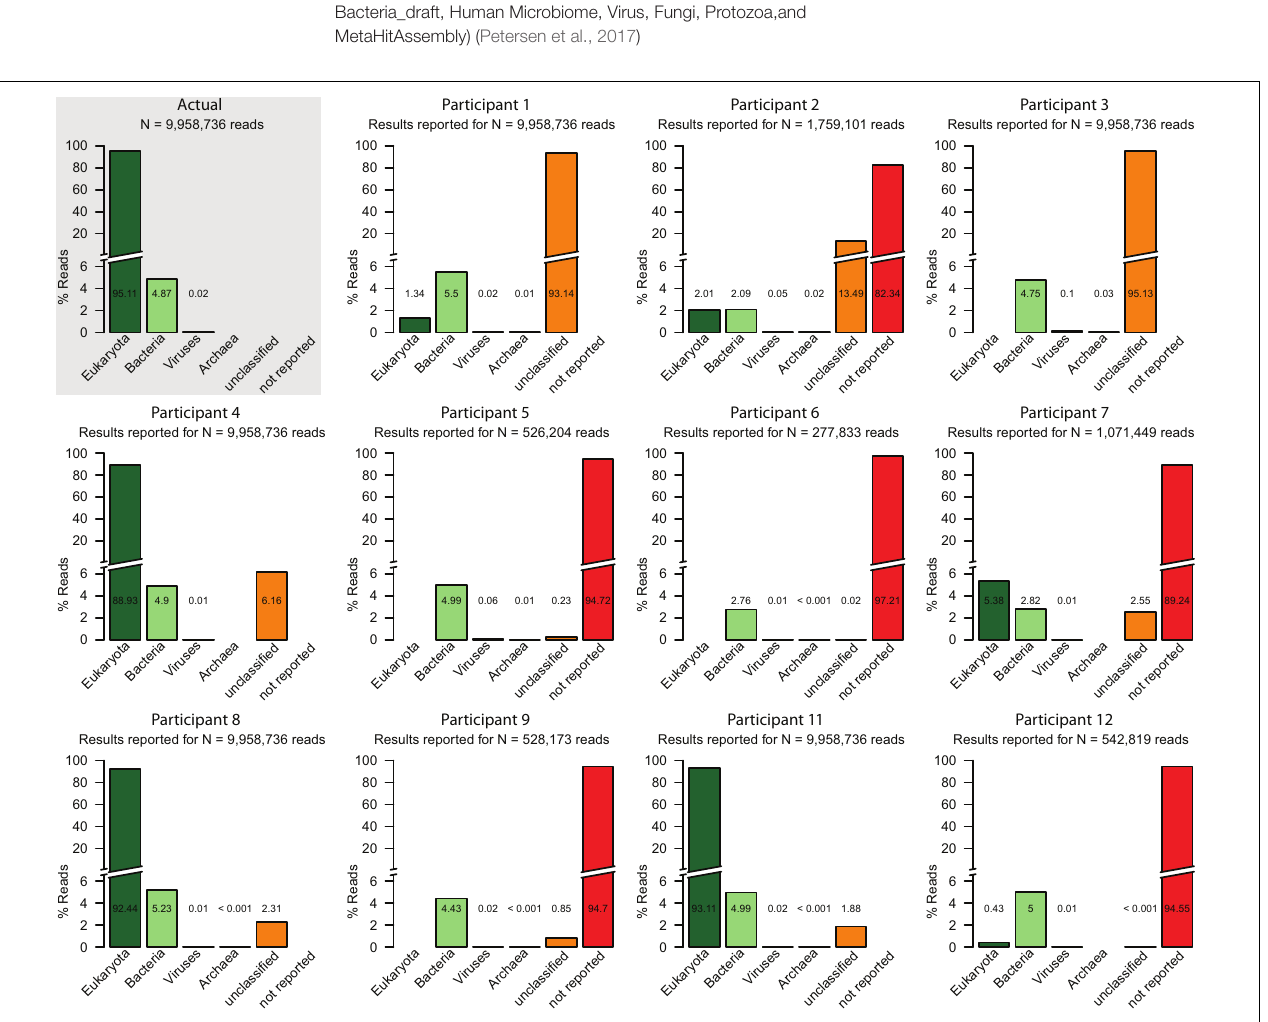
FIGURE 1 | Summary of the read assignments at the superkingdom-level for 11 participants that provided the requested read assignment table with the read to species assignments (except P10). Only five read assignment tables (P1, P3, P4, P8, and P11) contained an assignment for all reads of the dataset. Only the compositions reported by P4, P8, and P11 fit the known actual composition (actual; upper left) of the dataset.